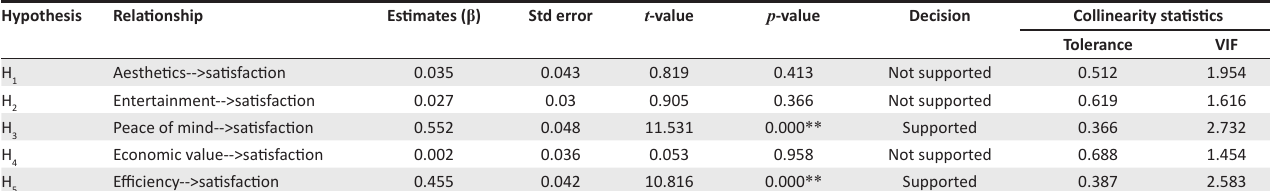
TABLE 5: Model hypotheses testing. Hypothesis